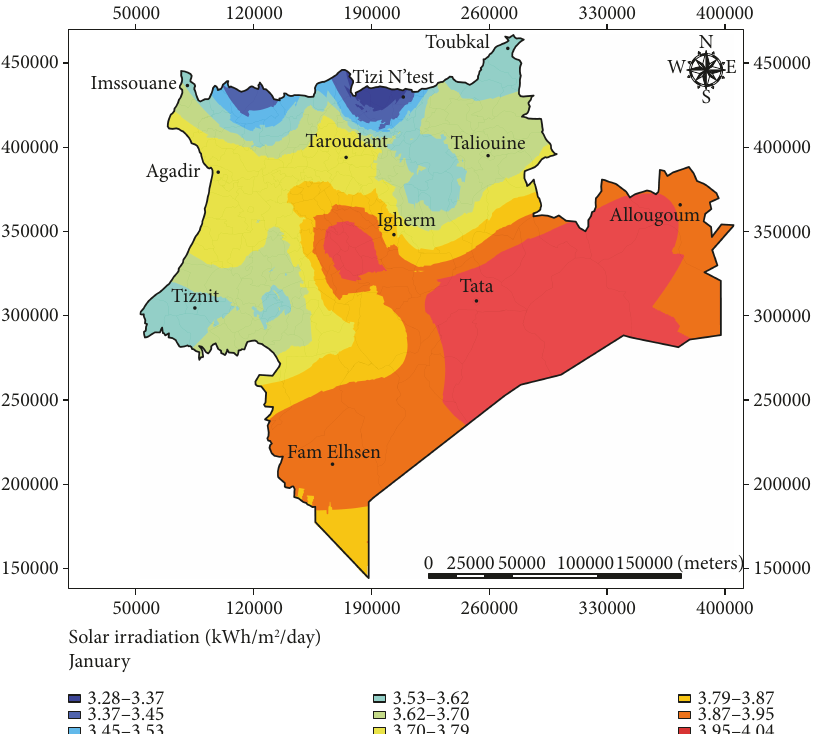
Figure 9: Solar energy potential map of the Souss-Massa area for the month of January as estimated by the ANN and designed with the Kriging interpolation technique.